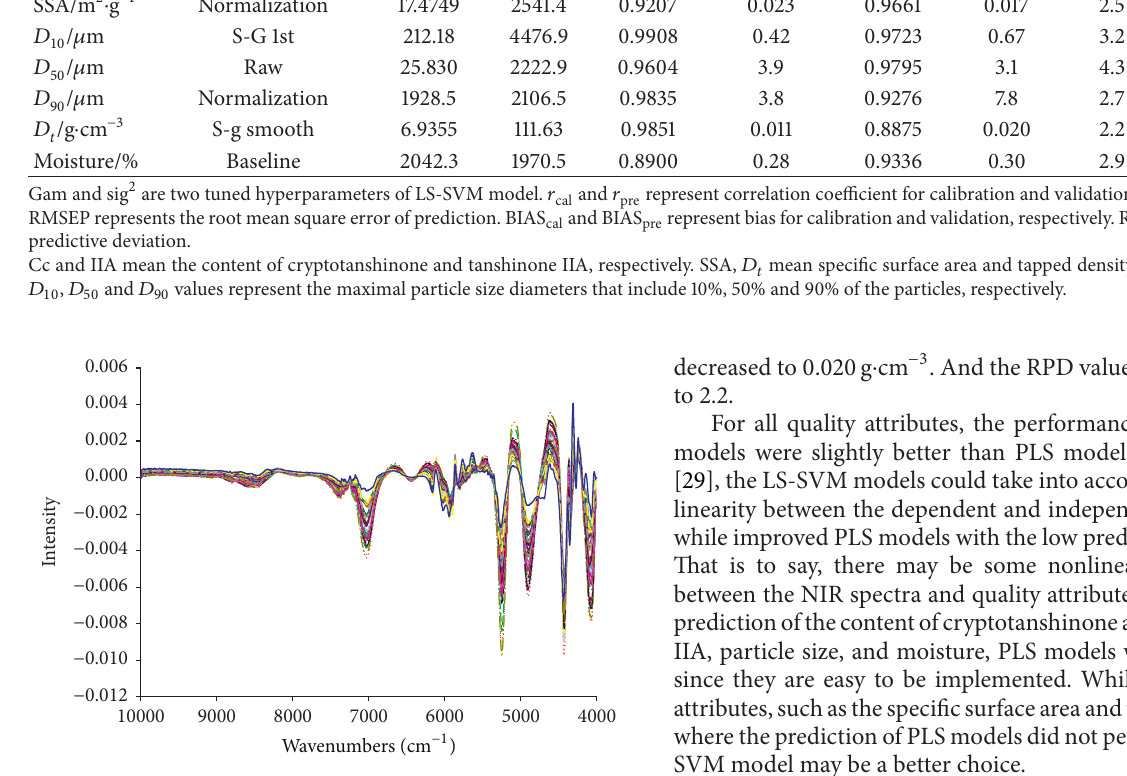
Figure 2: The near infrared spectra of 50 samples after Savitzky- Golay smoothing plus first-order